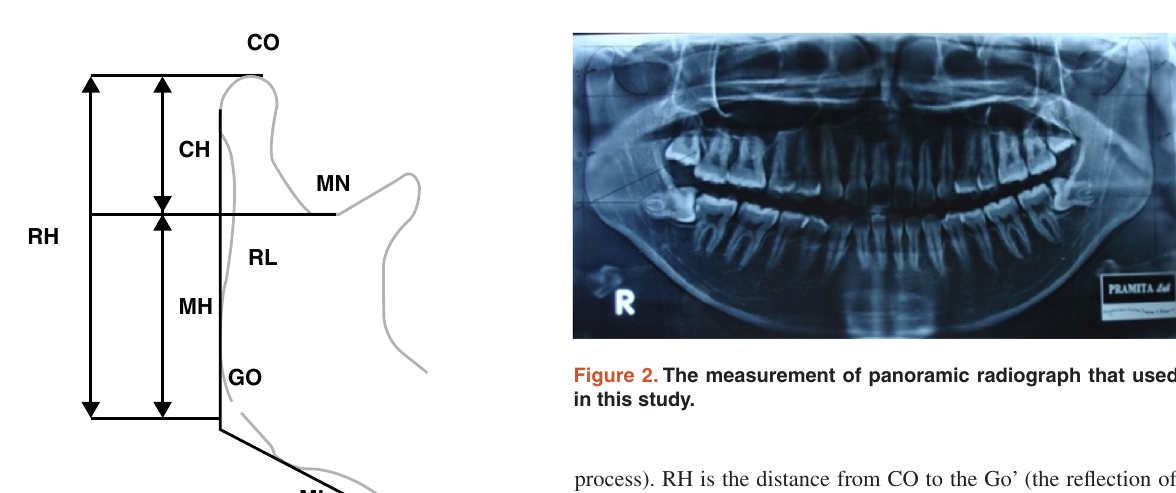
process). RH is the distance from CO to the Go’ (the reflection of subdivision tangen from ramus and corpus mandibular to the ramus borderline). In order to obtain vertical mandibular symmetry based on the ratio of condylar and ramus height (Kjellberg’s technique), the numerator should be